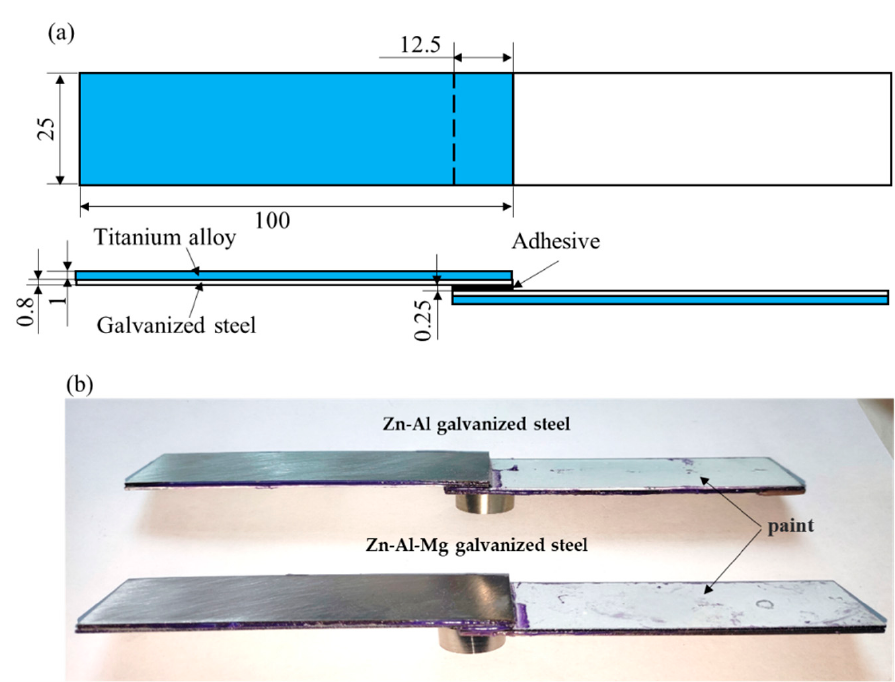
Figure 1. ( a ) Schematic diagram and ( b ) photograph of the galvanized steel joints.